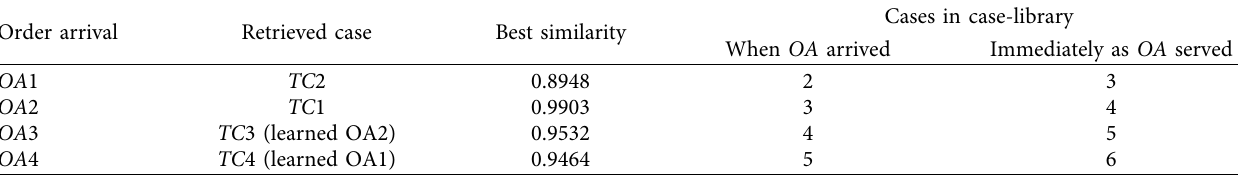
Table 6: Case retrieval results from proposed DSS.